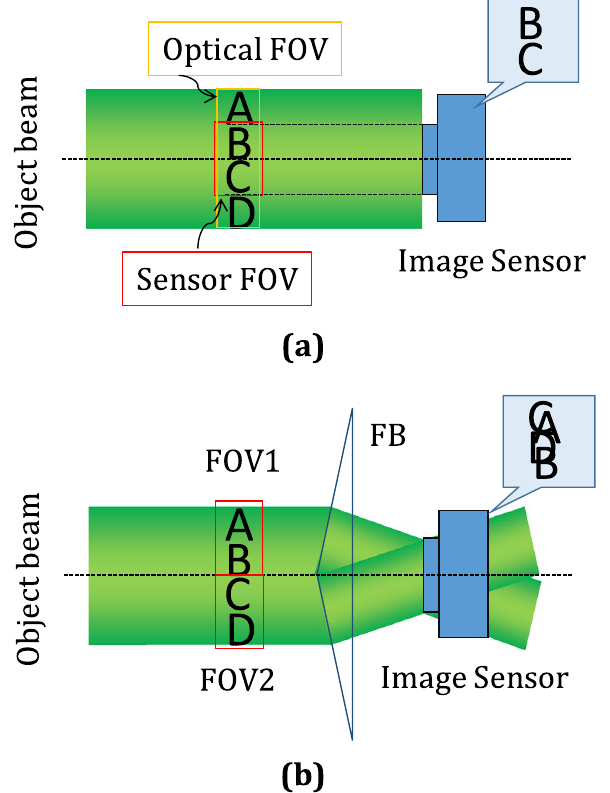
Figure 1. Two cases of FOV: ( a ) Limited FOV: without the use of Fresnel bi-prism records only the sensor FOV, and ( b ) Double FOV: with the use of Fresnel bi-prism to record two FOVs